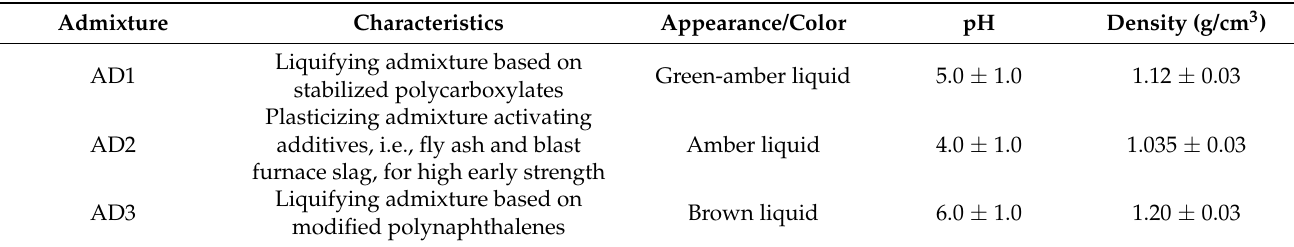
Table 3. Physical and chemical properties of the